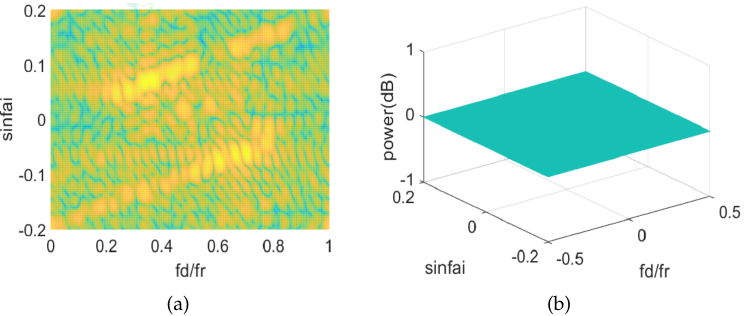
Figure 11. STAP results of traditional method: ( a ) two-dimensional frequency response plane diagram, ( b ) the output result after detection.